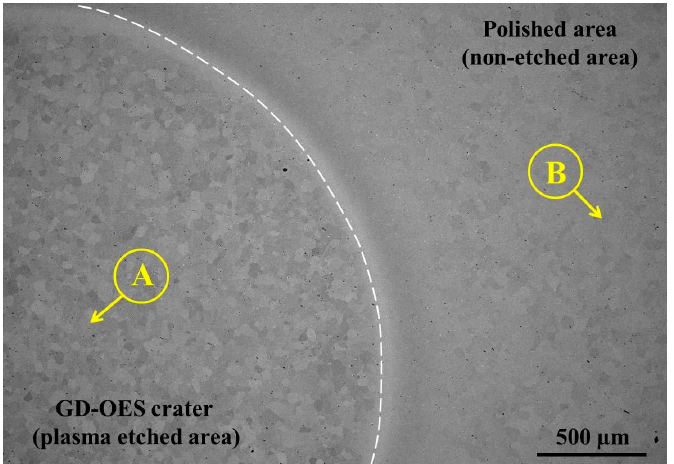
Figure 1. SEM/BSE image of the surface of steel 1.4509 (AISI 441) showing sputtered ( A ) and non-sputtered ( B ) areas.